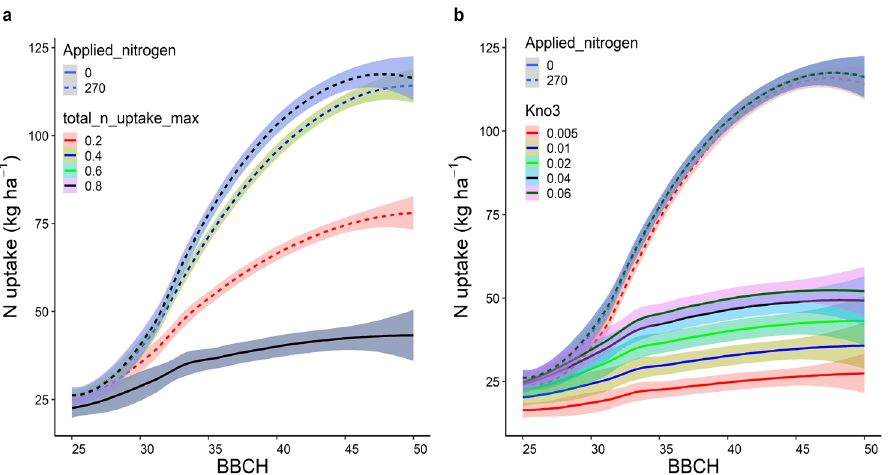
Figure 6. Sensitivity analysis of total_n_uptake_max ( a ) and kno3 ( b ) (g m −2 d −1 ) regulates maximum total N uptake based on root depth, and soil layers and their depths, respectively. Solid and dashed lines represent mean of three years (2016–2018) and shaded area is standard error. Applied nitrogen was in kg ha −1 .